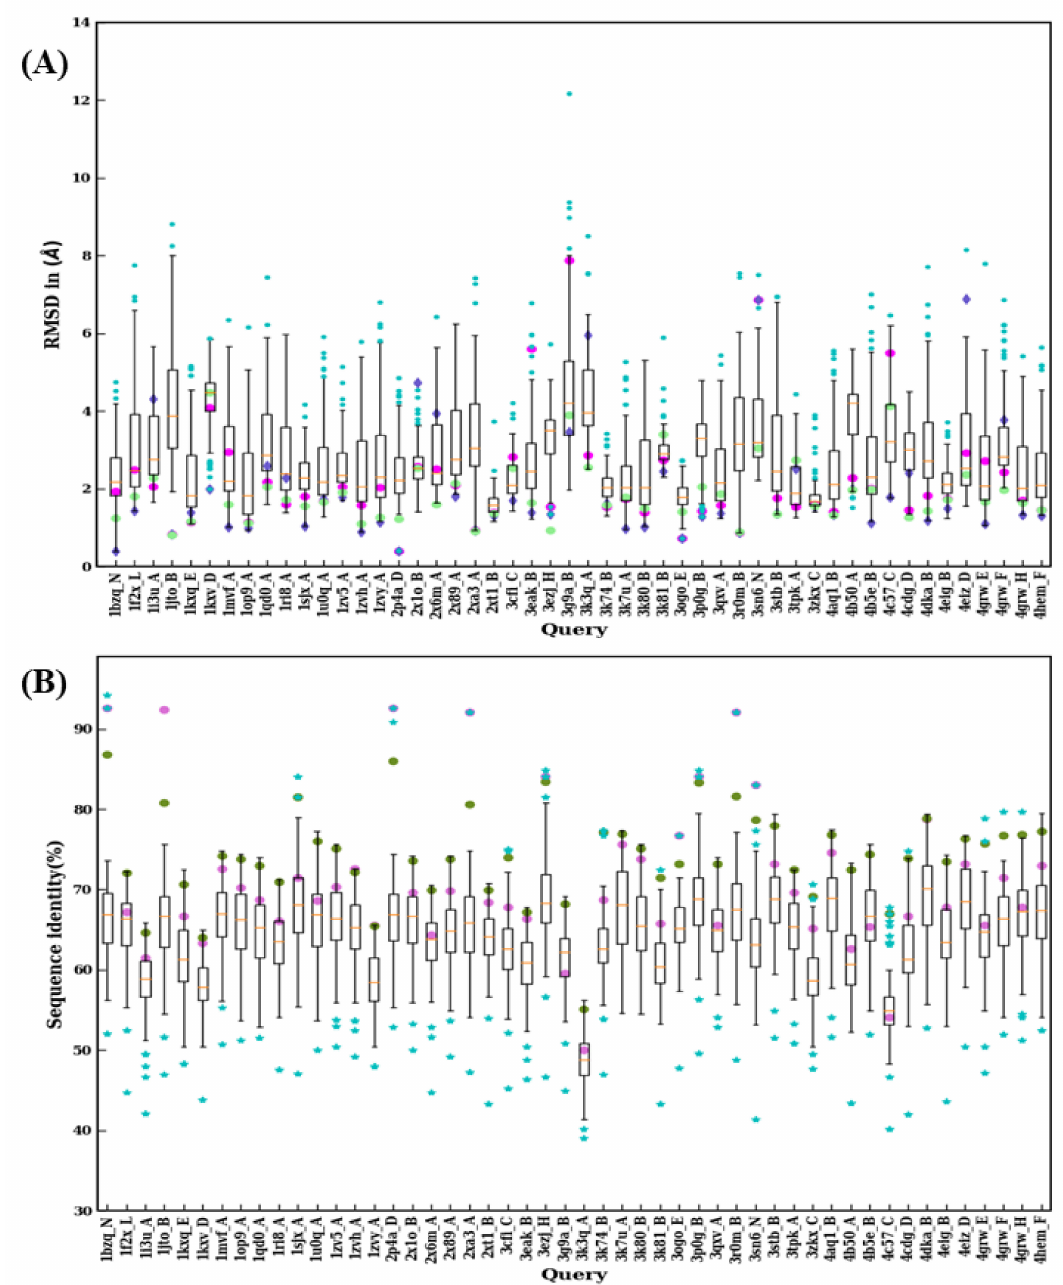
Figure 9. Structural similarity and sequence identity for first 50 V H H. ( A ) RMSD of best models from 99 modeling cases computed against the crystal structure. The RMSDs of best models from scenario 1, 2, and 3 are marked in magenta, purple, and green, respectively. ( B ) The values of sequence identities are shown. The sequence used in scenario 1 is in cyan at the upper limit, the one for scenario 2 is represented by a pink circle, and an olive green circle represents the average of the sequence identities, of the templates used for scenario